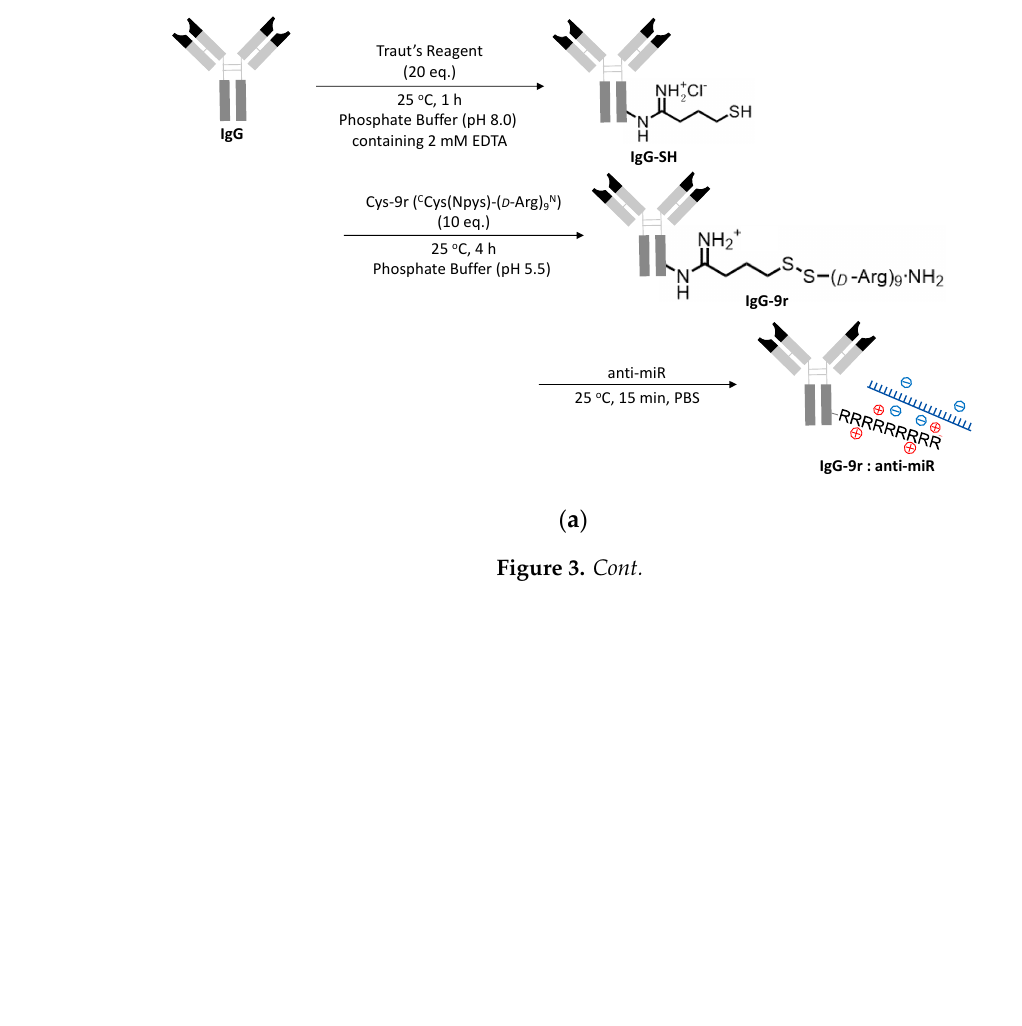
Figure 2. Cellular localization of fluorescently labeled anti-exosome antibodies (after 24 h of incubation) ( a ), analysis of the expression levels of antigens on the surfaces of exosomes and whole cell lysates by Western blotting ( b ), and exosome-dependent cellular uptake of anti-CD63 IgG in serum-free medium (after 12 h of incubation) ( c ).